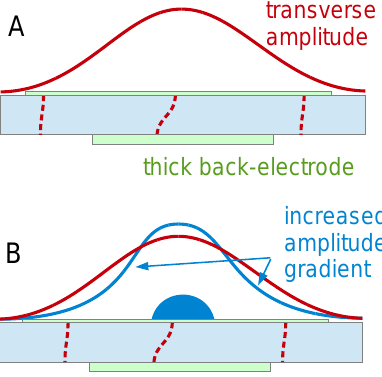
Figure 38. Application of a load to the center of the plate, only (as shown in panel ( B )), improves energy trapping, thereby increasing the resonance frequency with respect to the unloaded resonator in panel (shown in ( A )).